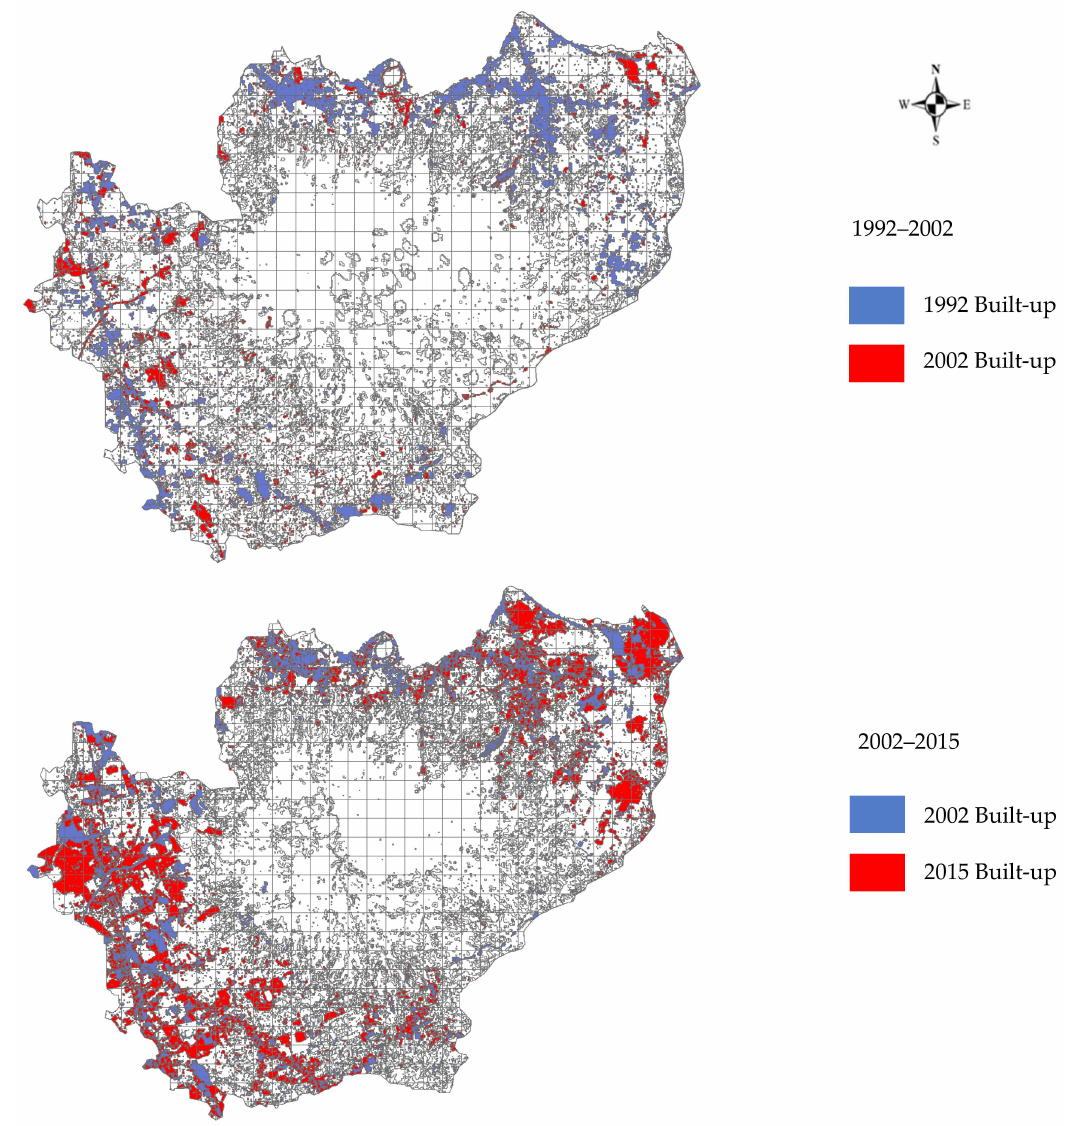
Figure 8. Urban Sprawl in MMFR Watersheds from 1992–2002 and 2002–2015.